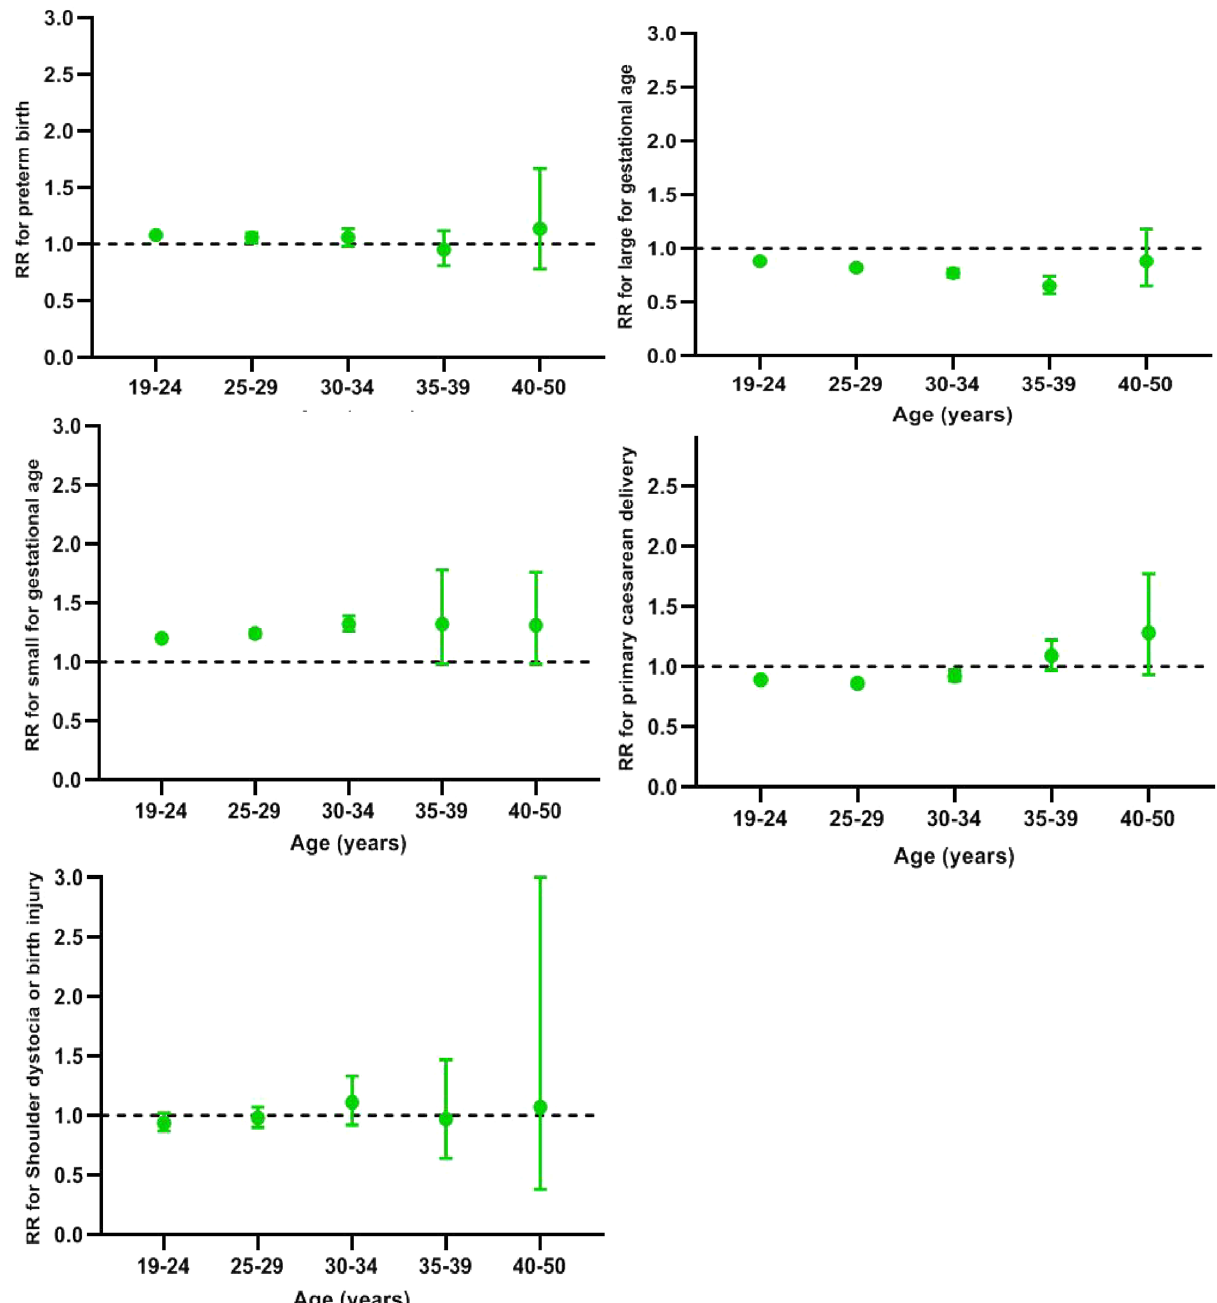
Figure 2. Association of pre-pregnancy underweight with the risks of 5 adverse pregnancy outcomes by maternal age